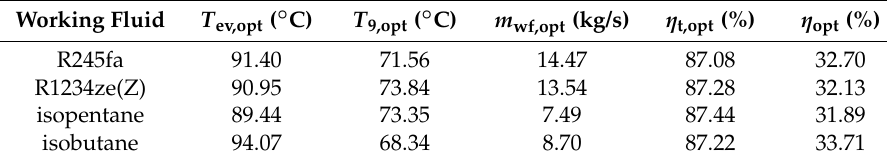
Figure 6. Plant exergy efficiency, reinjection temperature versus evaporating temperature. Table 4. Optimal working condition and performance without reinjection temperature limit.